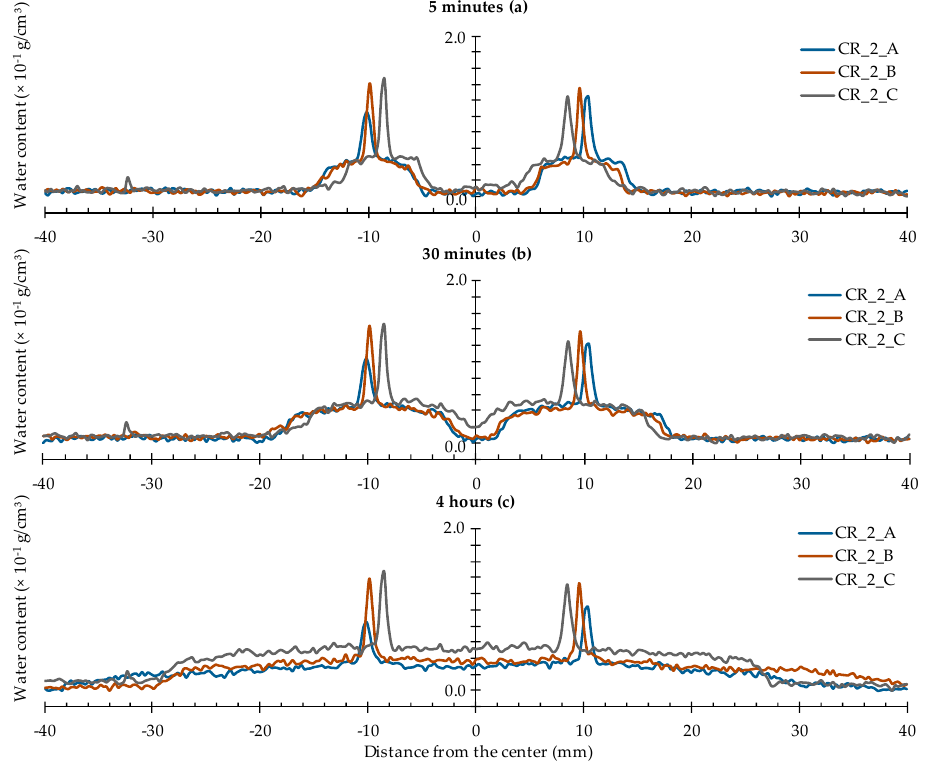
Figure 11. Water profiles of the three standard mortar prisms containing two artificial cracks: ( a ) after 5 min; ( b ) after 30 min; and ( c ) after 4 h.